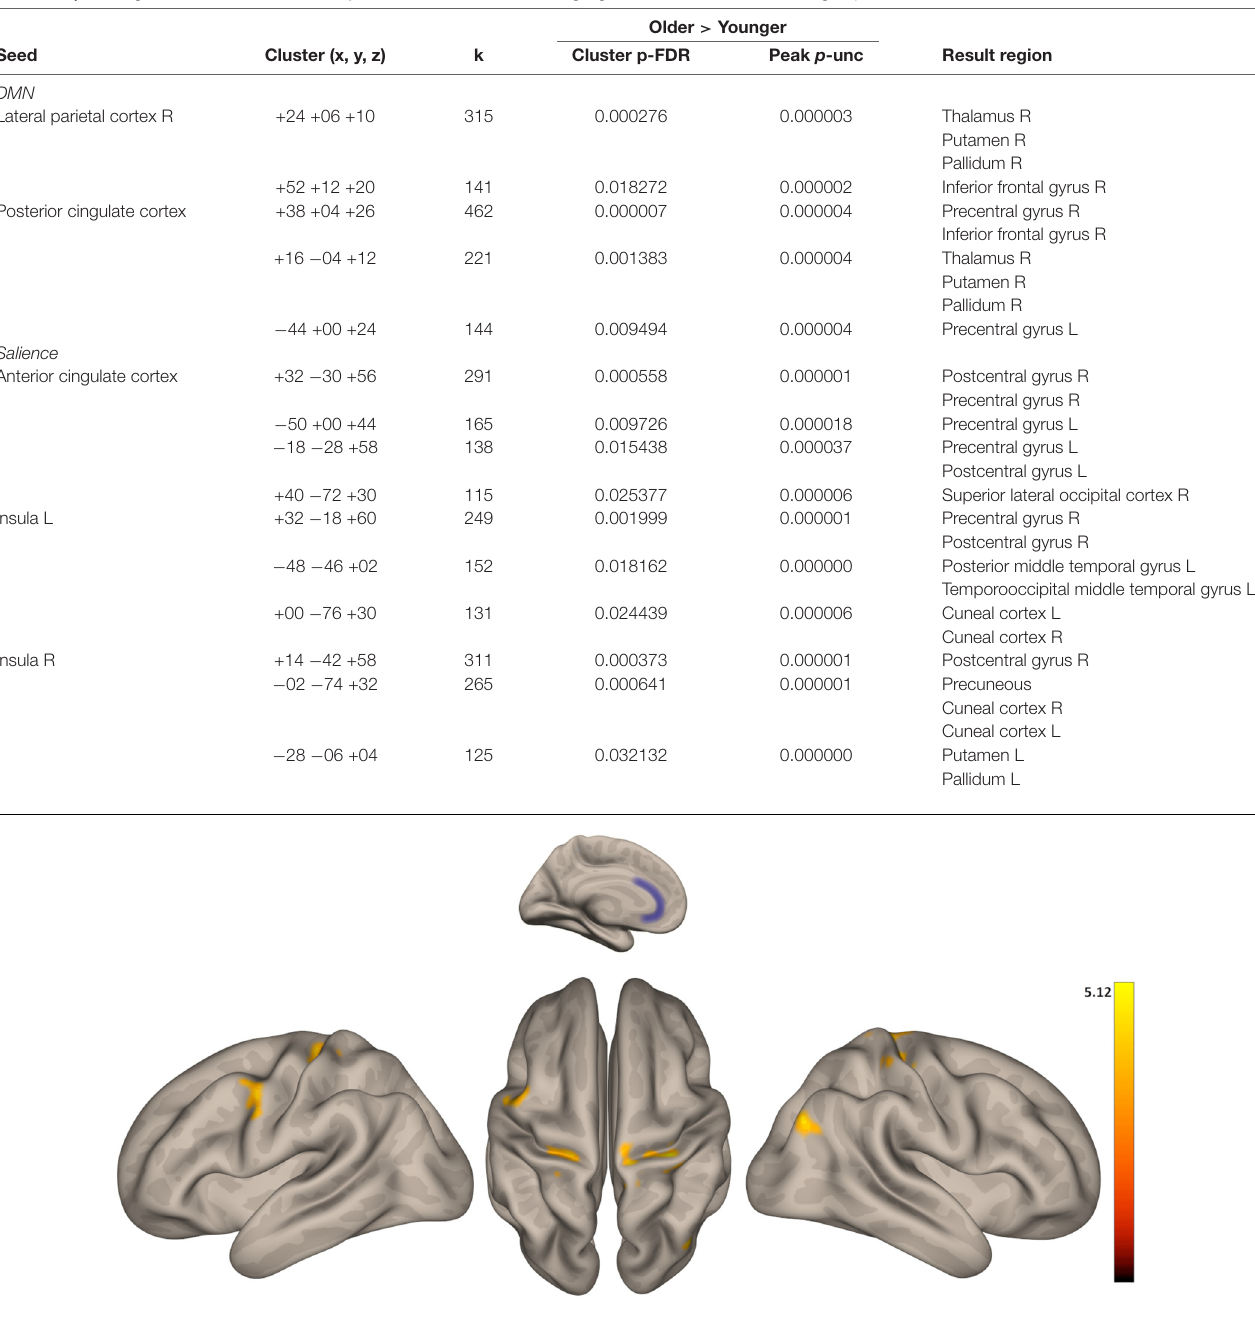
TABLE 2 | Resting-state functional connectivity between brain areas showing significant differences between groups.